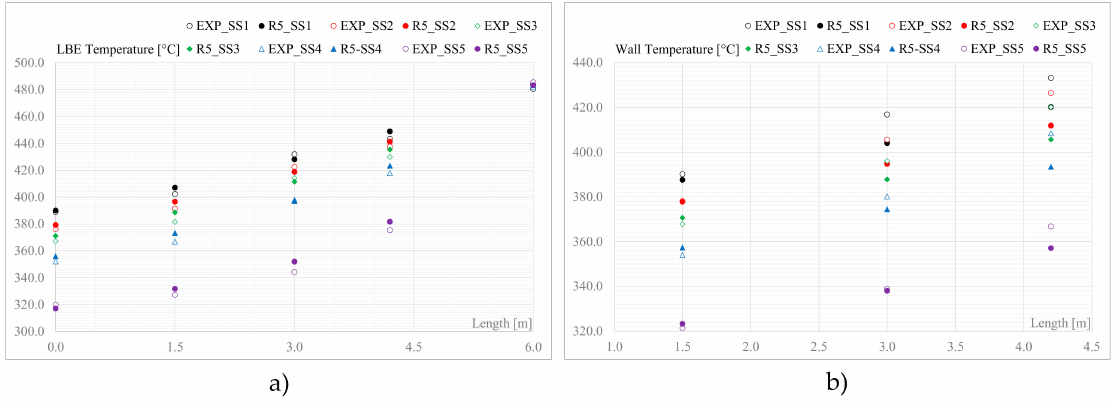
Figure 12. EF-T2, exp. vs. RELAP5-3D: ( a ) SG LBE bulk temperatures; ( b ) wall